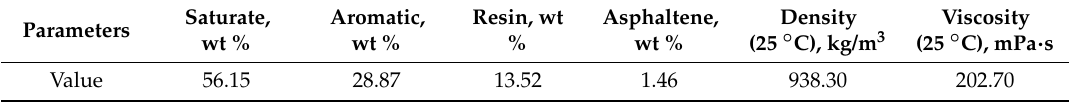
Table 3. Original heavy oil composition and basic physical properties.